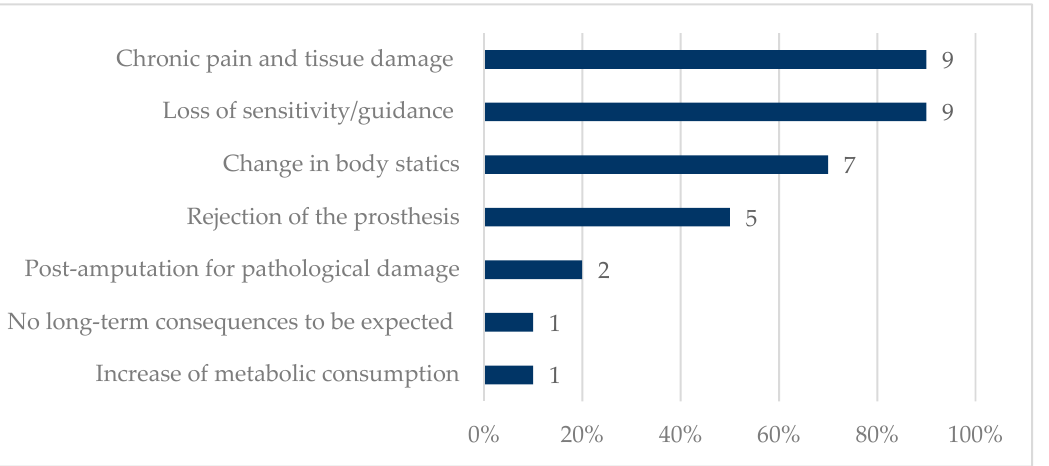
Figure 4. The psychological and physical long-term consequences of an unsuitable socket fit.